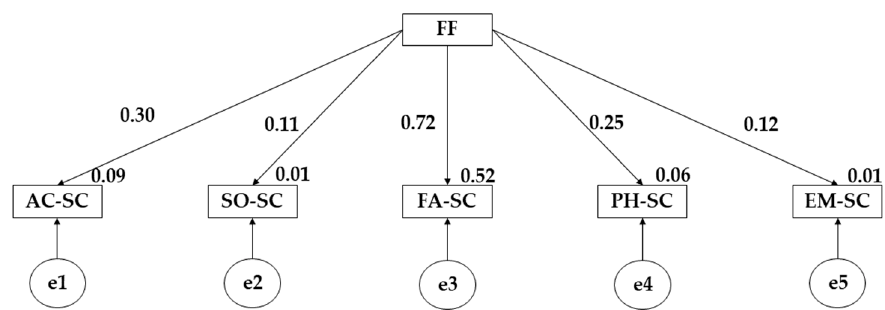
Figure 3. Model developed for students who practice less than 3 h of PA per week. Note: Family functionality (FF); Academic self-concept (AC-SC); Social self-concept (SO-SC); Family self-concept (FA-SC); Physical self-concept (PH-SC); Emotional self-concept (EM-SC).